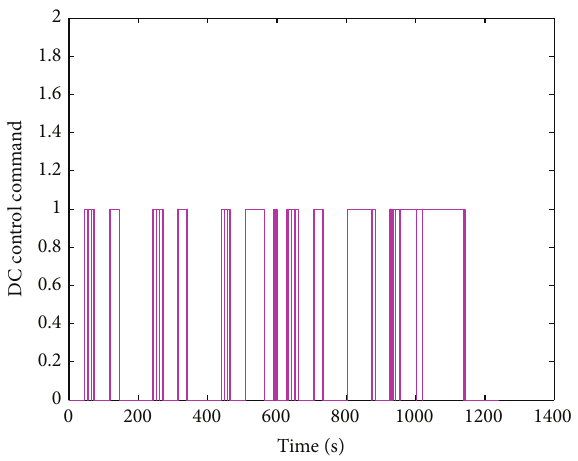
Figure 26: DC/DC converter control command.